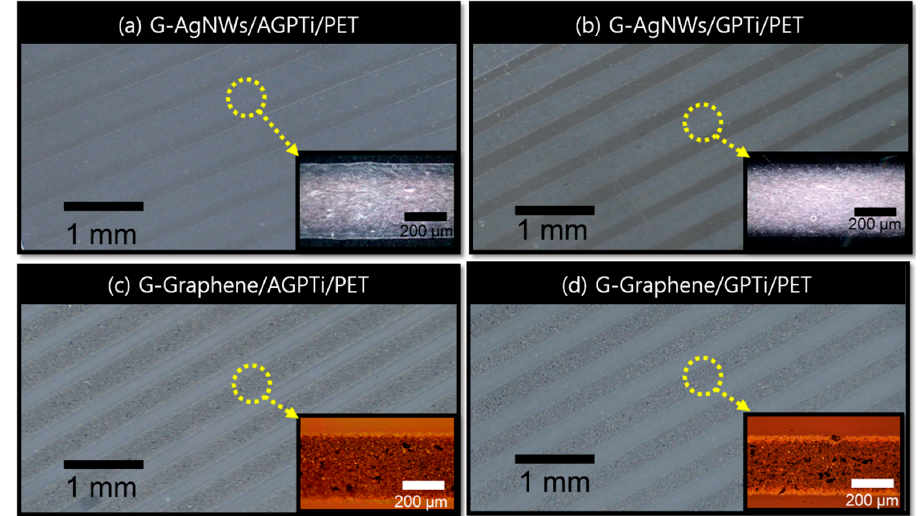
Figure 7. Gravure-printed lines of AgNWs and graphene on AGPTi (( a ) G-AgNWs/AGPTi/PET and ( c ) G-graphene/AGPTi/PET) and GPTi (( b ) G-AgNWs/GPTi/PET and ( d ) G-graphene/GPTi/PET), which were predeposited on PET.